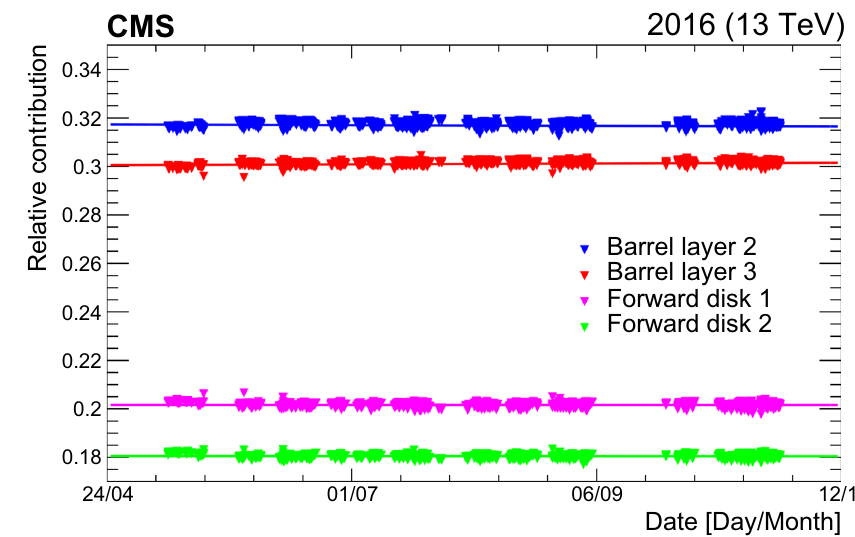
Fig. 16 The relative contribution to the total number of observed pixel clusters from the four regions of the pixel detector used in the luminosity measurement (barrel layers 2 and 3, and inner and outer forward pixel disks), as a function of time throughout 2016. The lines represent first-order polynomial fits to the relative contributions from each region